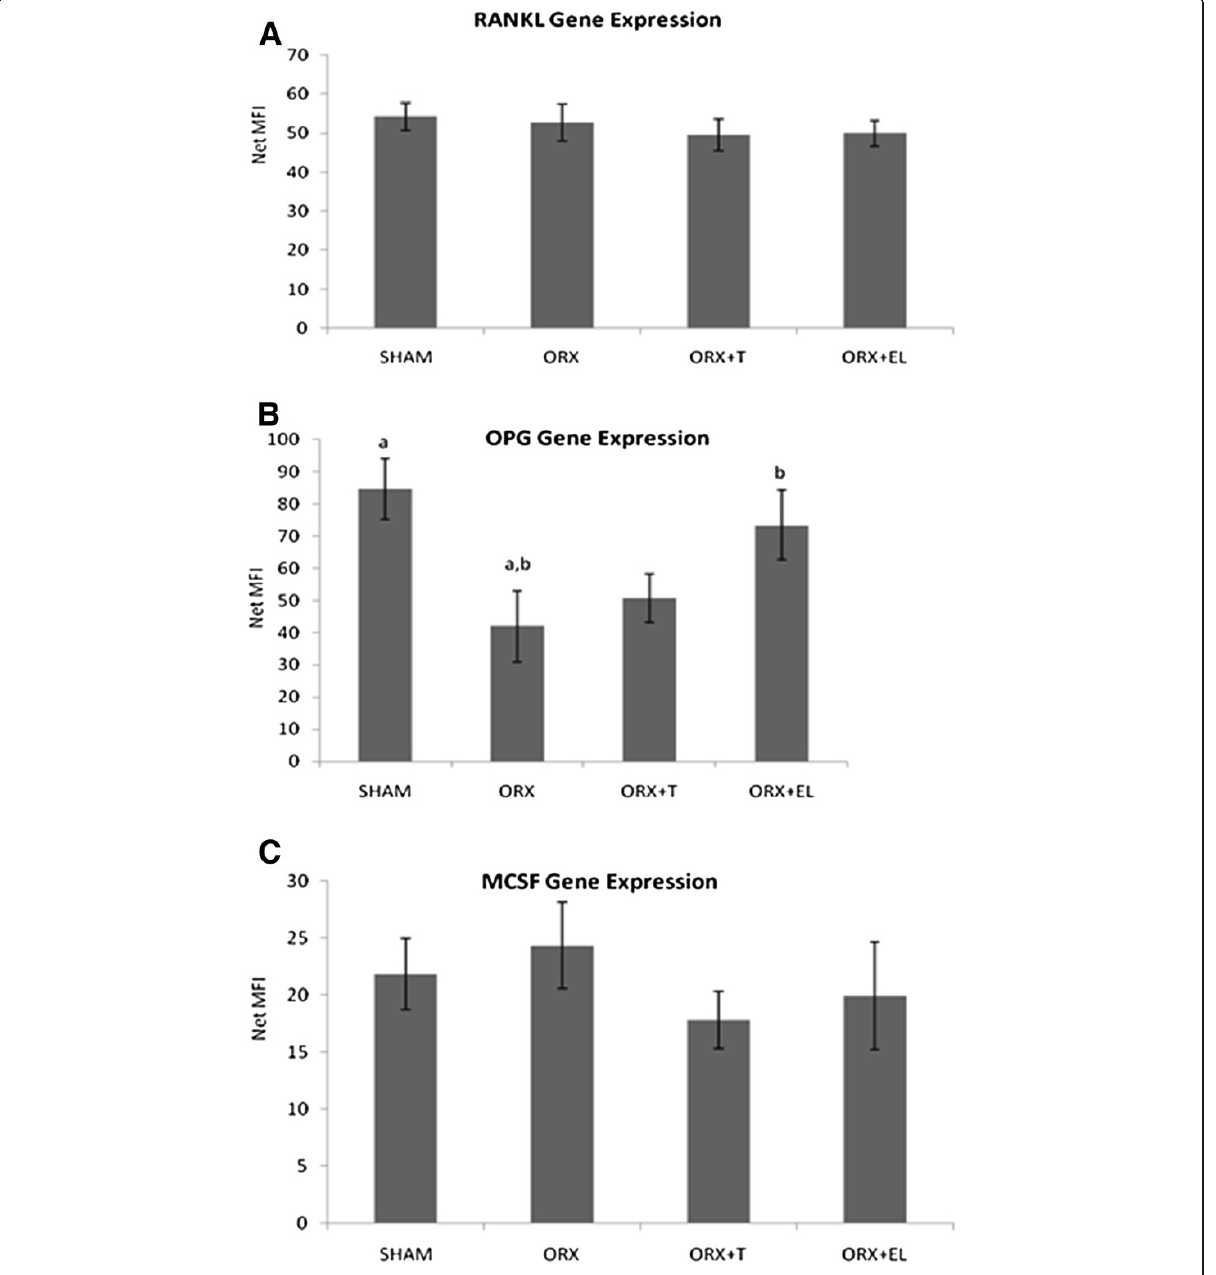
Figure 5 A, B and C: The RANKL, OPG, M-CSF gene expressions for all the groups. Samples were normalized to GAPD MFI (Median Fluorescence Intensity). Error bars represented the standard deviations of the average responses. Significant difference was taken at p < 0.05. SHAM : Sham- operated group. ORX : Orchidectomized control group. ORX + T : Orchidectomized group treated by testosterone. ORX + EL : Orchidetctomized group treated with